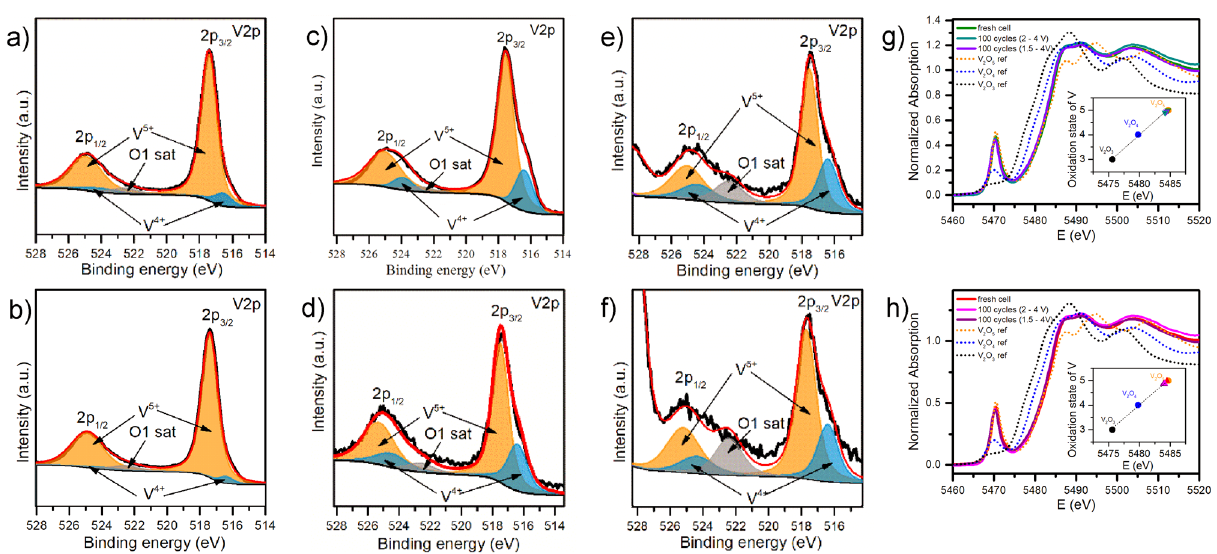
Figure 6. ( a–f ) Ex-situ high resolution XPS spectra of the V2p regions in pristine ( a ) KVO-20, and ( b ) KVO-40 electrode, and a fully discharged state of the KVO-20 and KVO-40 electrode after 100 charges/discharge test at j = 1 A g −1 in two potential ranges: 2.0-4 V ( c, d ) for KVO-20 and KVO-40 respectively), and 1.5–4 V ( e,f ) for KVO-20 and KVO-40 respectively); ( g,h ) Ex-situ V K-edge XANES spectra of the pristine electrodes and a fully discharged state after 100 charges/discharges test at j = A g −1 in two potential ranges: 2.0–4.0 and 1.5–4.0 for ( g ) KVO-20 and ( h ) KVO-40,